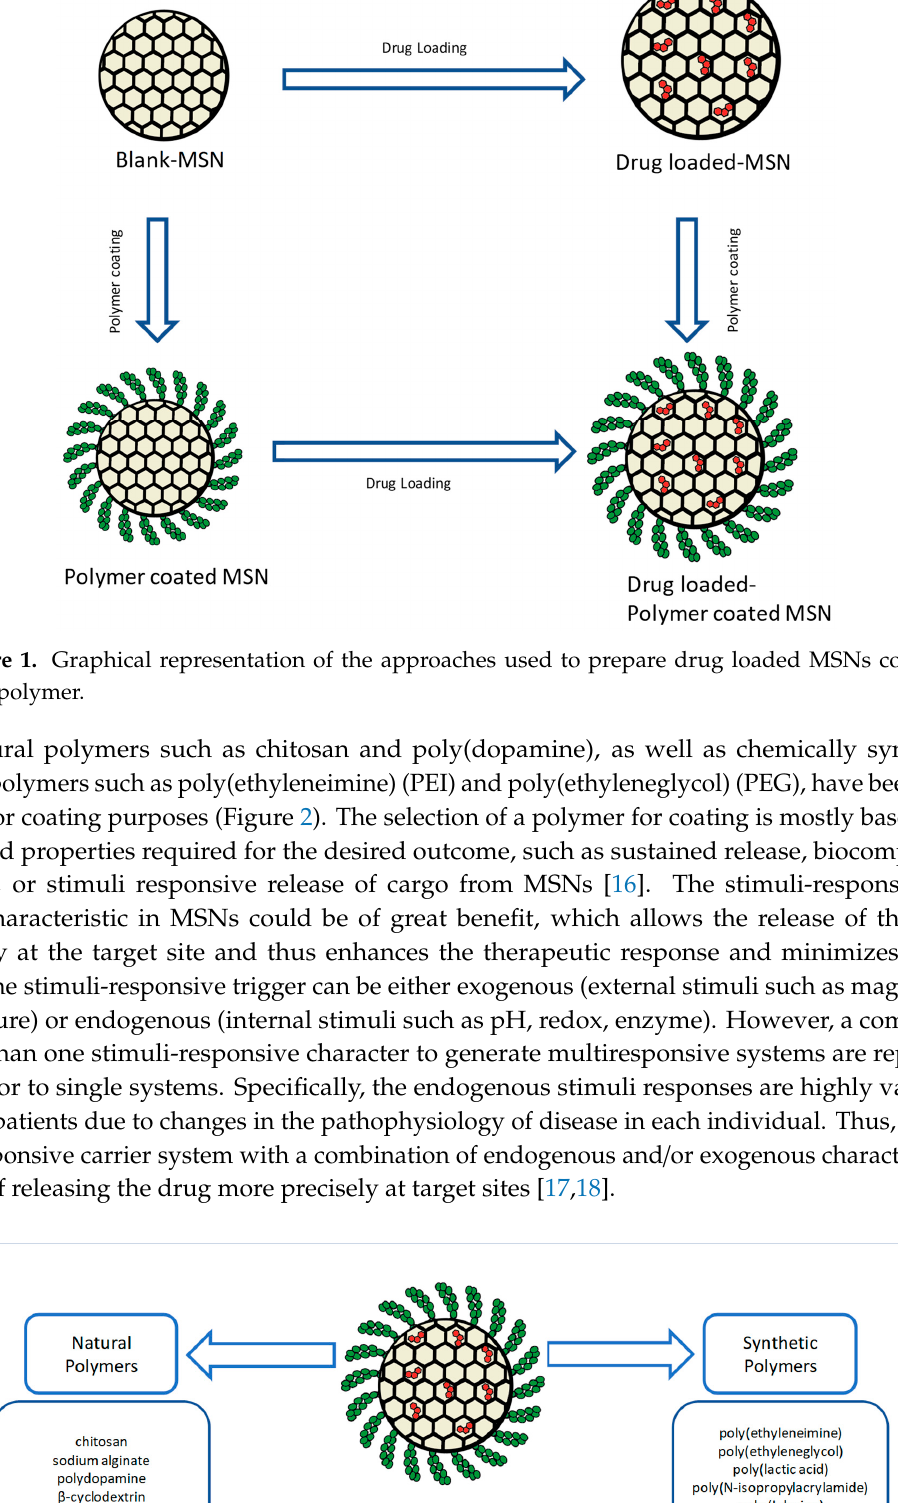
Figure 3. Biological disorders that have been targeted using polymer coated mesoporous silica nanoparticles. 2. Polymer Coated MSNs for Cancer Nanocarriers find enormous application potential in the diagnosis and treatment of cancer due to their capability of providing controlled release and targeted therapy. MSNs, due to their high surface area, tunable pore size, and flexible surface modification possibilities, along with good biocompatibility, have been prominently employed in cancer treatment research. In addition, the surface coating of MSNs offers the opportunity of achieving stimuli-responsive drug release at target sites, thus decreasing the systemic toxic effect of antineoplastic drugs [19]. Internal as well as external stimuli are widely explored for the selective release of drugs at tumor sites. Several polymers have